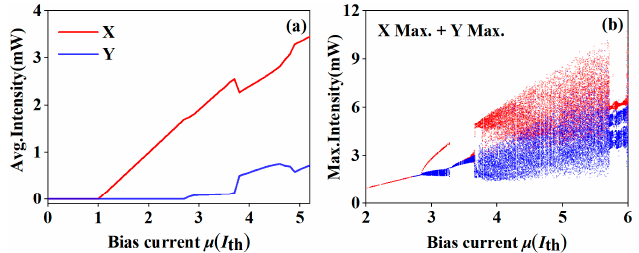
Figure 2. ( a ) Average output intensity of the XP (red line) and YP (blue line) modes as a function of bias current μ ; ( b ) Bifurcation diagram of the local maximum of the XP (red dots) and YP (blue dots) output intensity versus the bias current μ .